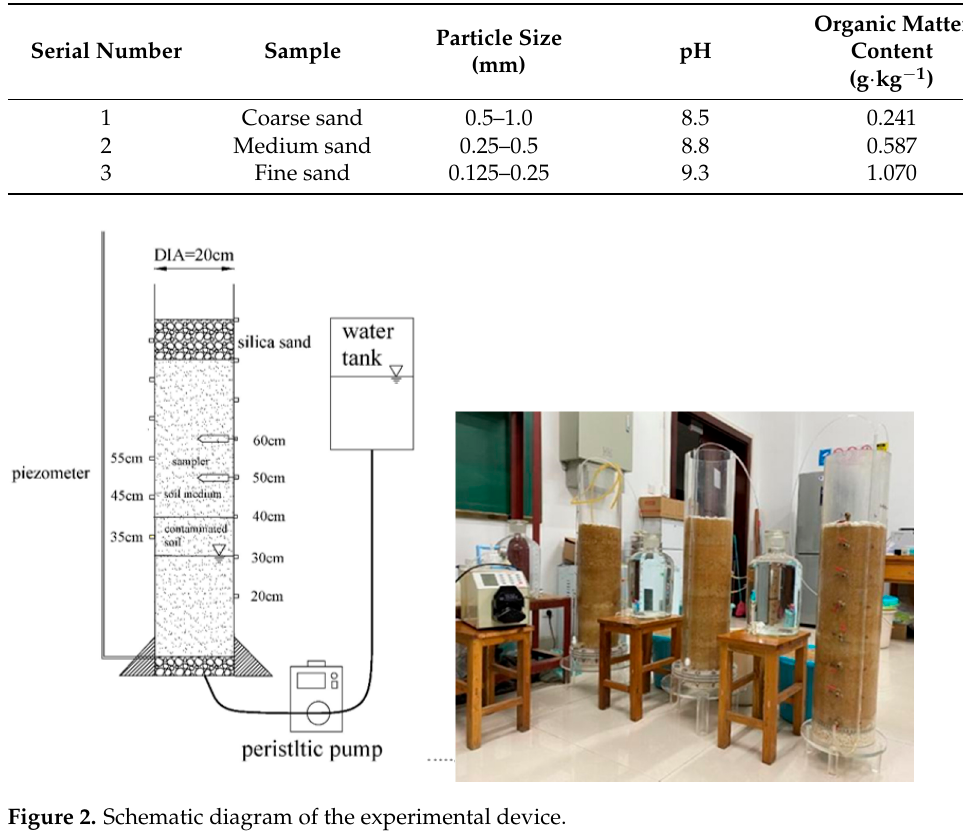
Figure 2. Schematic diagram of the experimental device.